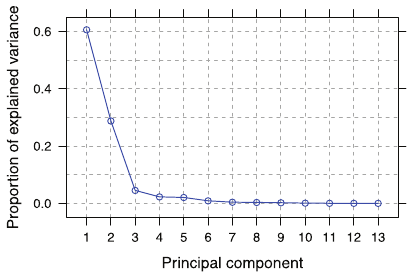
Figure 6. Importance of the principal components of the texture parameters.